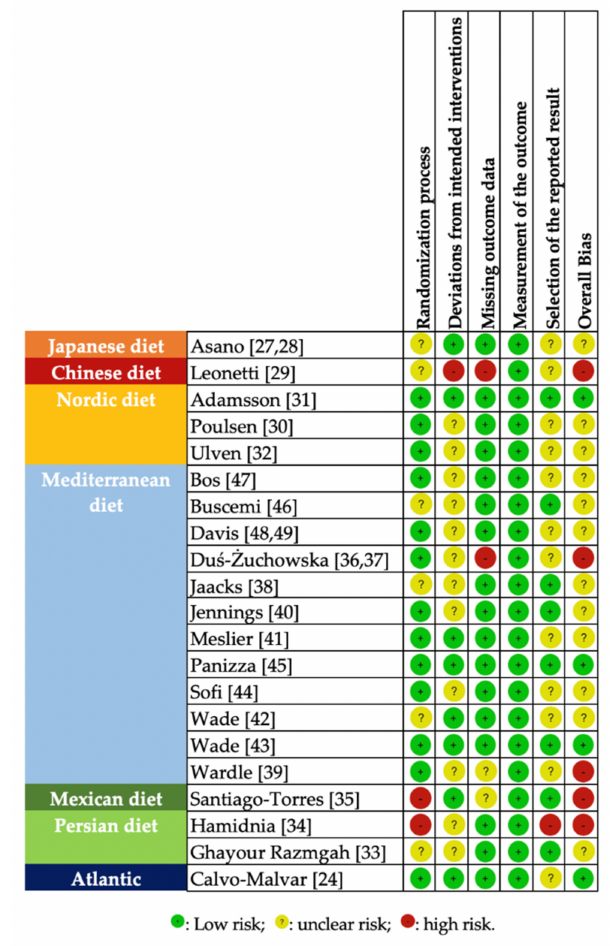
Figure 4. Randomized controlled trials, investigating the effects of MD interventions, rated by the Cochrane risk of bias tool